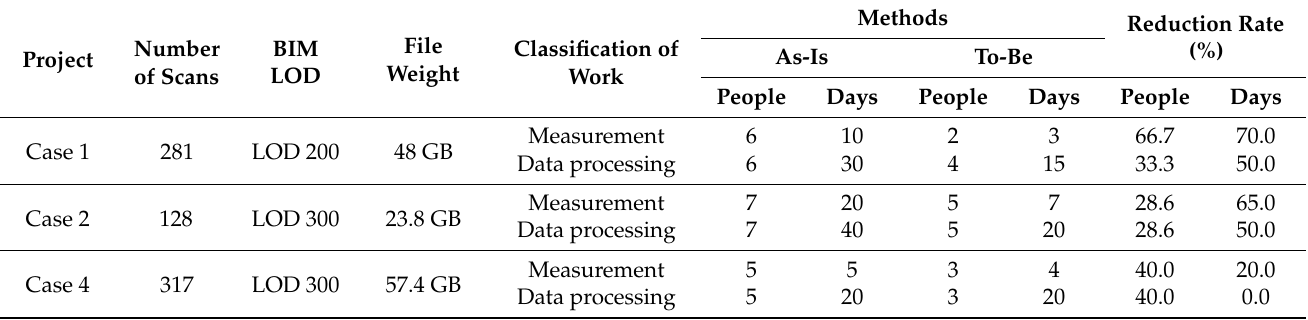
Table 4. Comparison of labor input between the traditional and TLS methods (as-is vs.